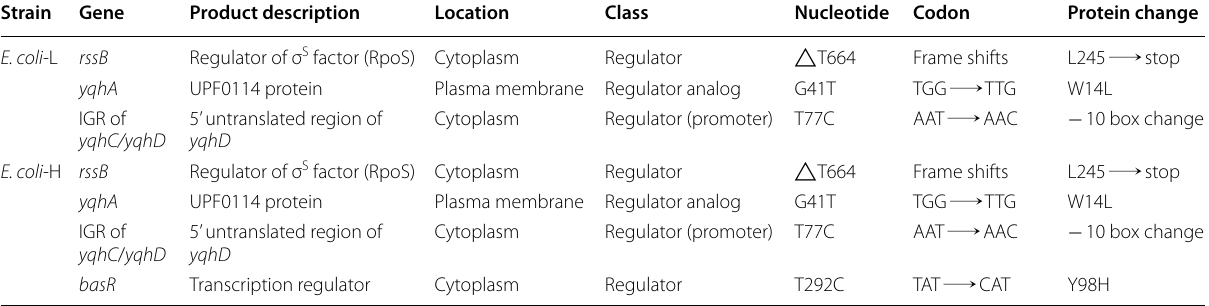
Table 2 Confirmed mutations discovered in two E. coli LGE2-evolved strains adapted to inhibitors-containing LB media Strain